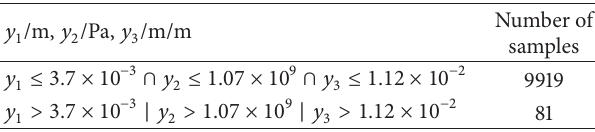
Table 3: Multiobject sampling statistics of